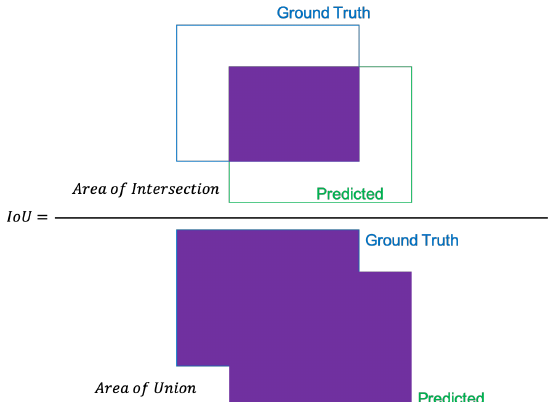
Figure 5. Computing the Intersection of Union, IoU , calculated by dividing the area of overlap between the bounding boxes by the area of